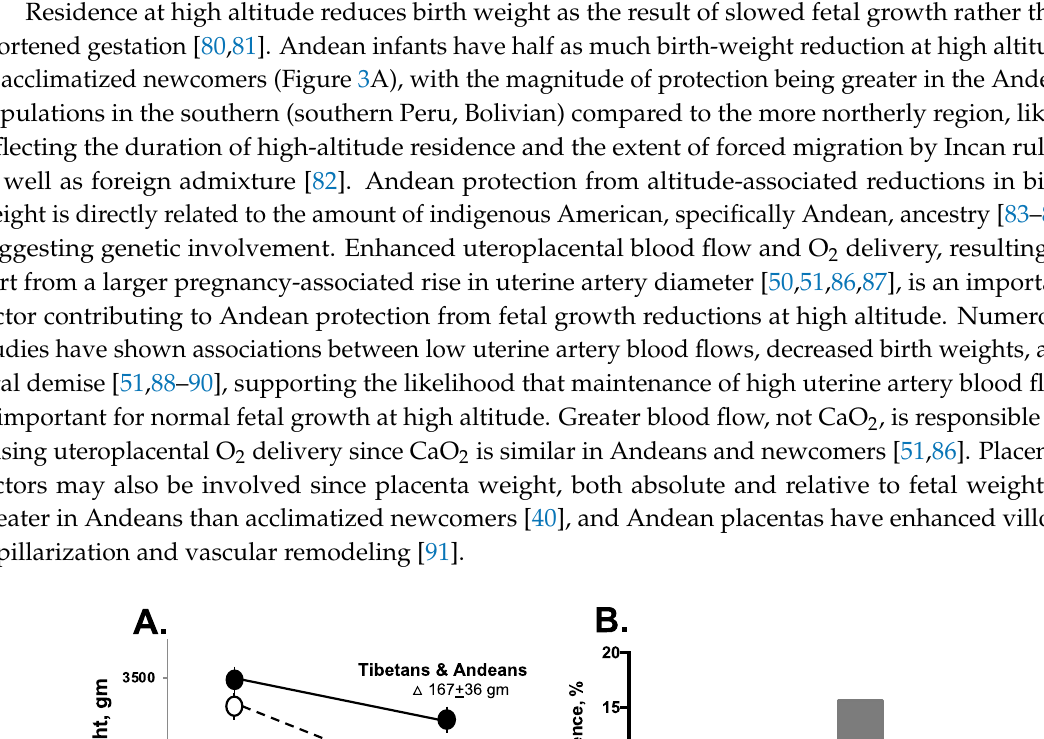
Figure 2. Adaptive challenges or those affecting reproductive success occur at high altitudes at multiple times across the lifespan. About half the cluster during the perinatal period or that from gestation through to the first week of postnatal life, with the remainder occurring during adolescence or adulthood (see text for references). Adapted from [12].